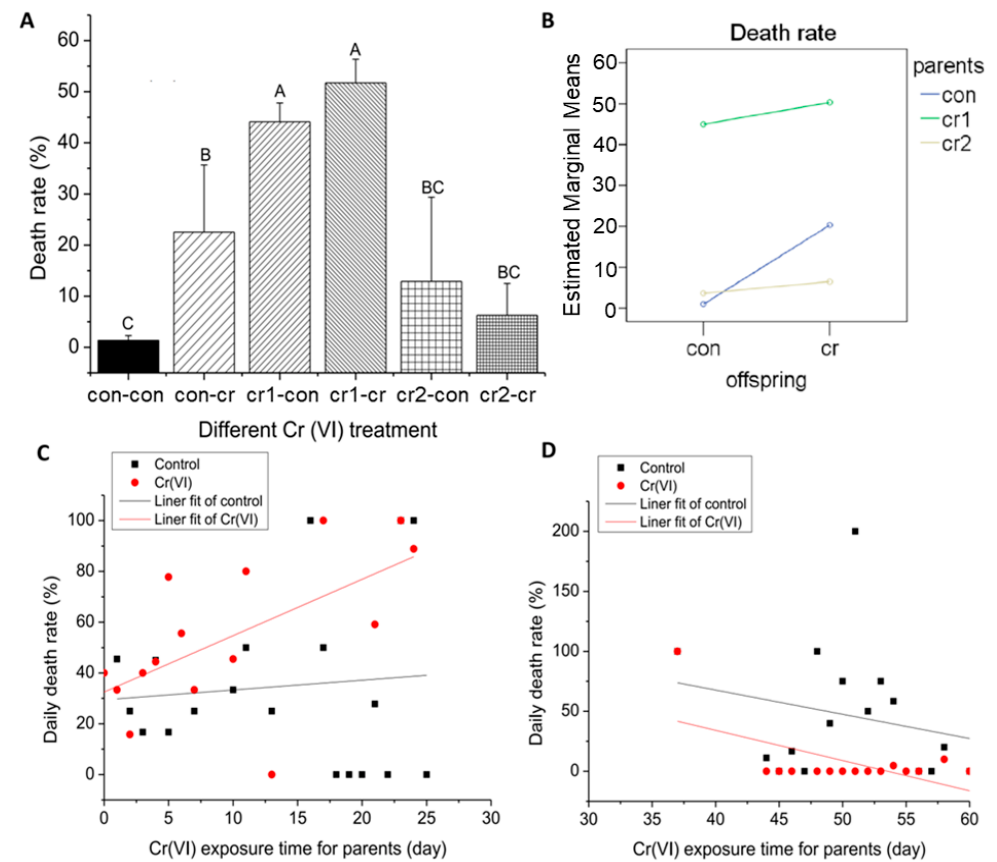
Figure 3. The change of death rate after long-term Cr(VI) exposure in marine medaka offspring. ( A ) the death rate of offspring under different Cr(VI) treatment, different upper case means the significant differences among different treatment ( p ≤ 0.001); ( B ) the interaction of parent and offspring Cr(VI) treatment for death rate ( p = 0.000); ( C , D ) daily death rate under different offspring Cr(VI) exposure after parental Cr(VI) exposure, X axis represents parental treatment, and Y axis represents daily death rate, the blank line represents offspring in control environment, the red line represents offspring in Cr(VI) environment; ( C ) parental Cr(VI) exposure for first month, the function relationships between exposure time and death rate were y = 0.3858x + 29.42182, R 2 = − 0.04964 (untreated offspring) and y = 2.22099x + 32.4783, R 2 = 0.31578 (treated offspring); ( D ) parental Cr(VI) exposure for second month, the function relationships between exposure time and death rate were y = − 2.01x + 148.4, R 2 = − 0.01 (untreated offspring) and y = − 2.51x + 134.7, R 2 = 0.292 (treated offspring). The number of biological samples used for each group is as follow: con-con ( N = 486), con-cr ( N = 81), cr1-con ( N = 145), cr1-cr ( N = 159), cr2-con ( N = 90), cr2-cr ( N =